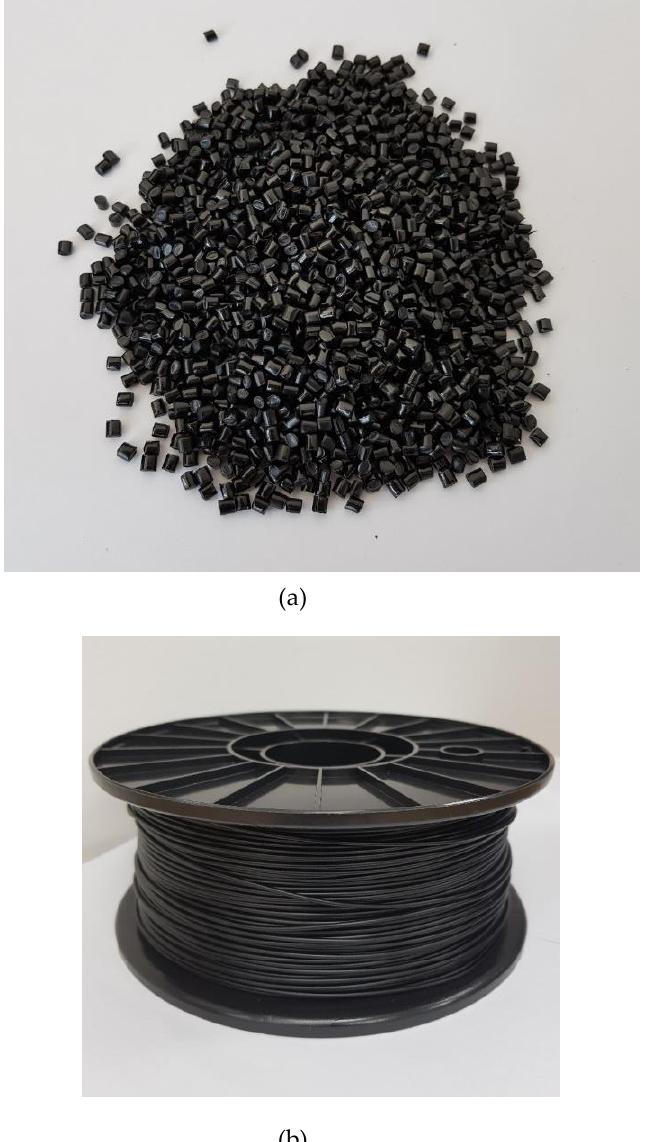
Figure 1. ( a ) Pellets and ( b ) filaments of the Multi-walled carbon nanotubes / thermoplastic polyurethane (MWCNT/TPU) composite.